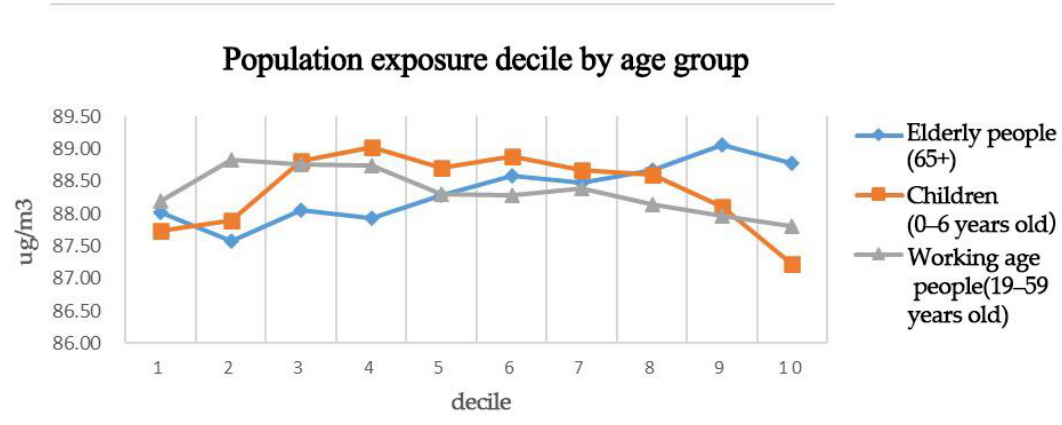
Figure 7. Population decile-weighted PM 2.5 concentrations by age group.